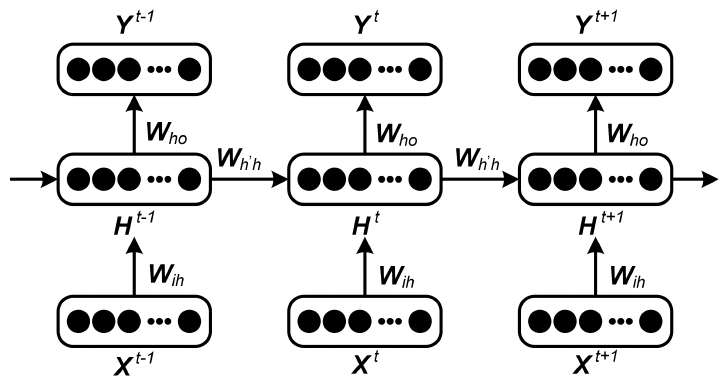
Figure 1. A simple RNN structure, where X is the input unit, H is the hidden unit, Y is the output unit, and W is the weight